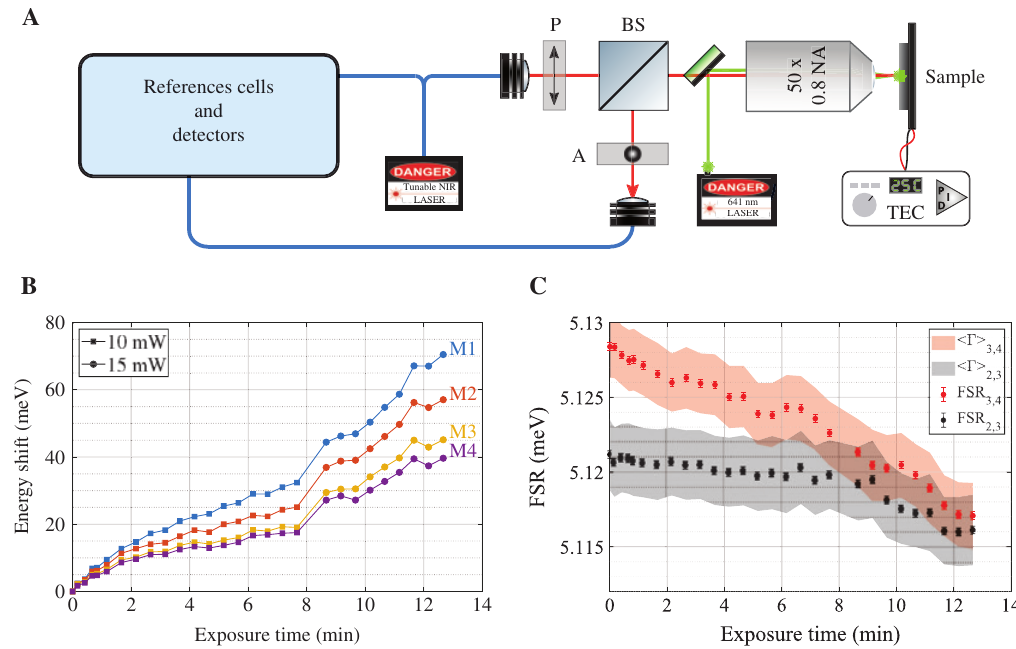
Figure 3: Schematic of the setup for mode-selective tuning via local oxidation and experimental results. (A) Schematic of the experimental apparatus (see Supplementary Information for details). Notice that the same RS apparatus used for the sample characterization is exploited for the tuning. (B) Energy shift of the first four modes after local oxidation operated at the center of the PhC cavity. The vertical dashed line marks the increase of the oxidation power from 10 mW to 15 mW. The total shift depends on the mode order, with a more pronounced effect on lower order modes and a maximum overall shift of 69 μ eV for the fundamental. (C) FSR shifts of the pairs of modes 2, 3 and 3, 4 exploited in the tuning experiment. The average linewidths (full width half maximum) of the pairs of modes involved are represented as shaded areas. Error bars, which are specifically evaluated for each tuning step, are systematically smaller than mode